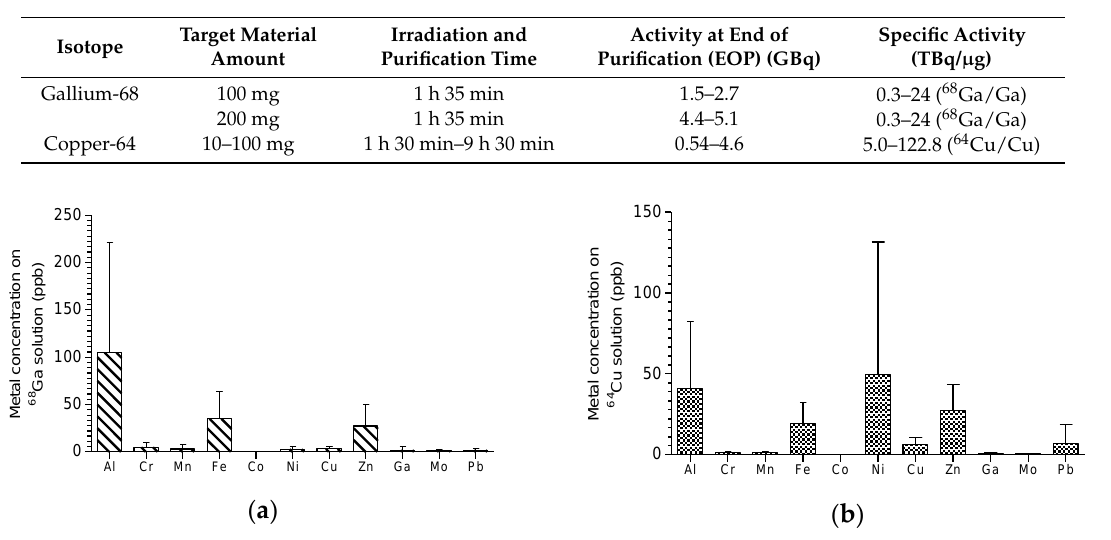
Table 2. Purified activities obtained and respective specific activity.